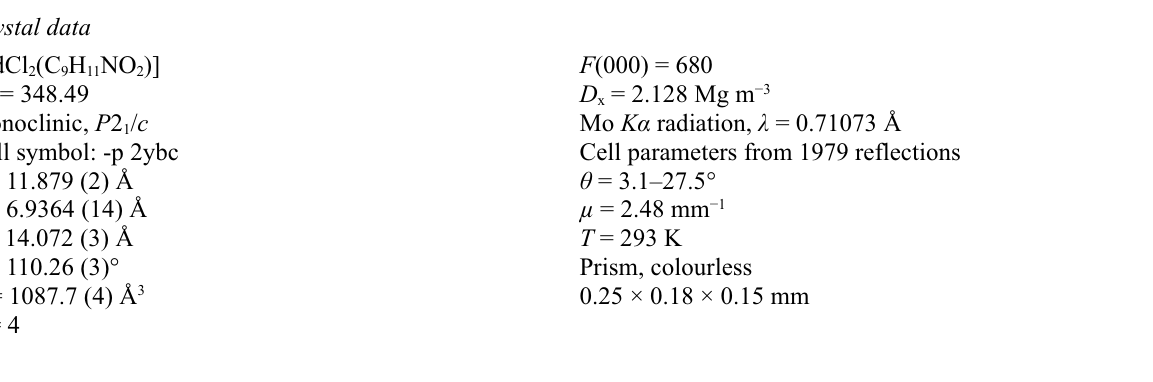
Packing diagram of the title compound, showing the structure along the b axis. H atoms have been omitted for clarity. catena-Poly[cadmium(II)-( µ -3-ammonio-3-phenylpropanoato- κ 2 O : O ′ )-di- µ